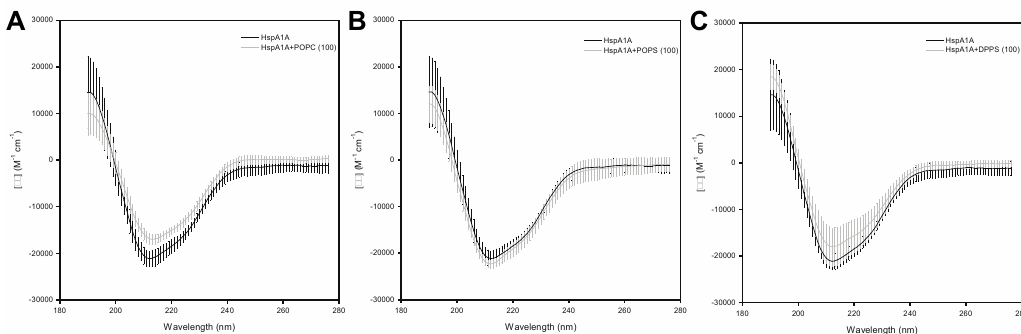
Figure 2. Circular dichroism (CD) experiments reveal subtle alterations of the secondary structure of